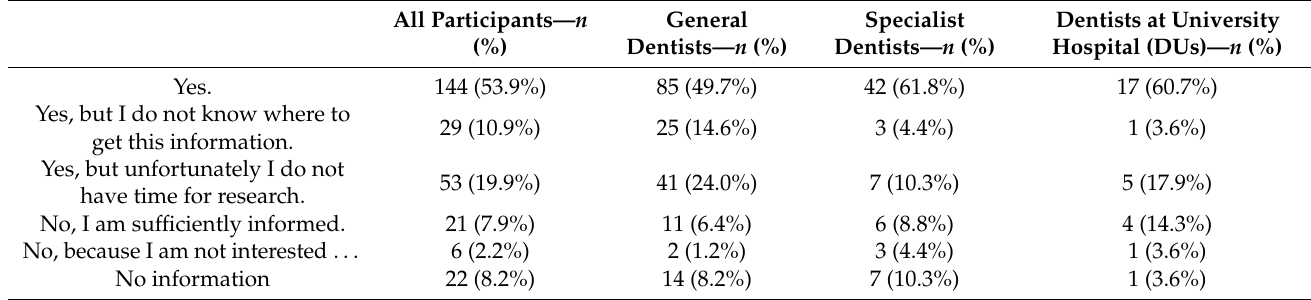
Table 3. Do you need information concerning rare diseases with orofacial manifestations in your everyday dental practice?